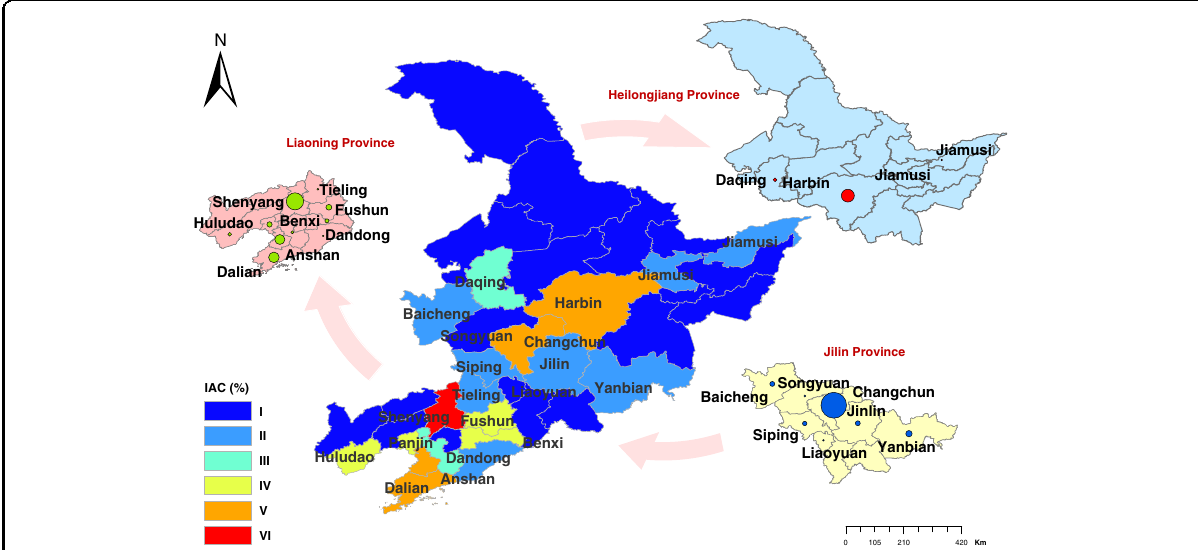
Fig. 1 Spatial distribution of the IAC at prefecture-level cities in Northeast China in 2017. The gradient six colors represent the severity of IAC on a scale from I to VI. (i.e., I: 0 – 0.5%; II: 0.5 – 2%; III: 2 – 5%; IV: 5 – 15%; V: 15 – 30% and VI: 30 –